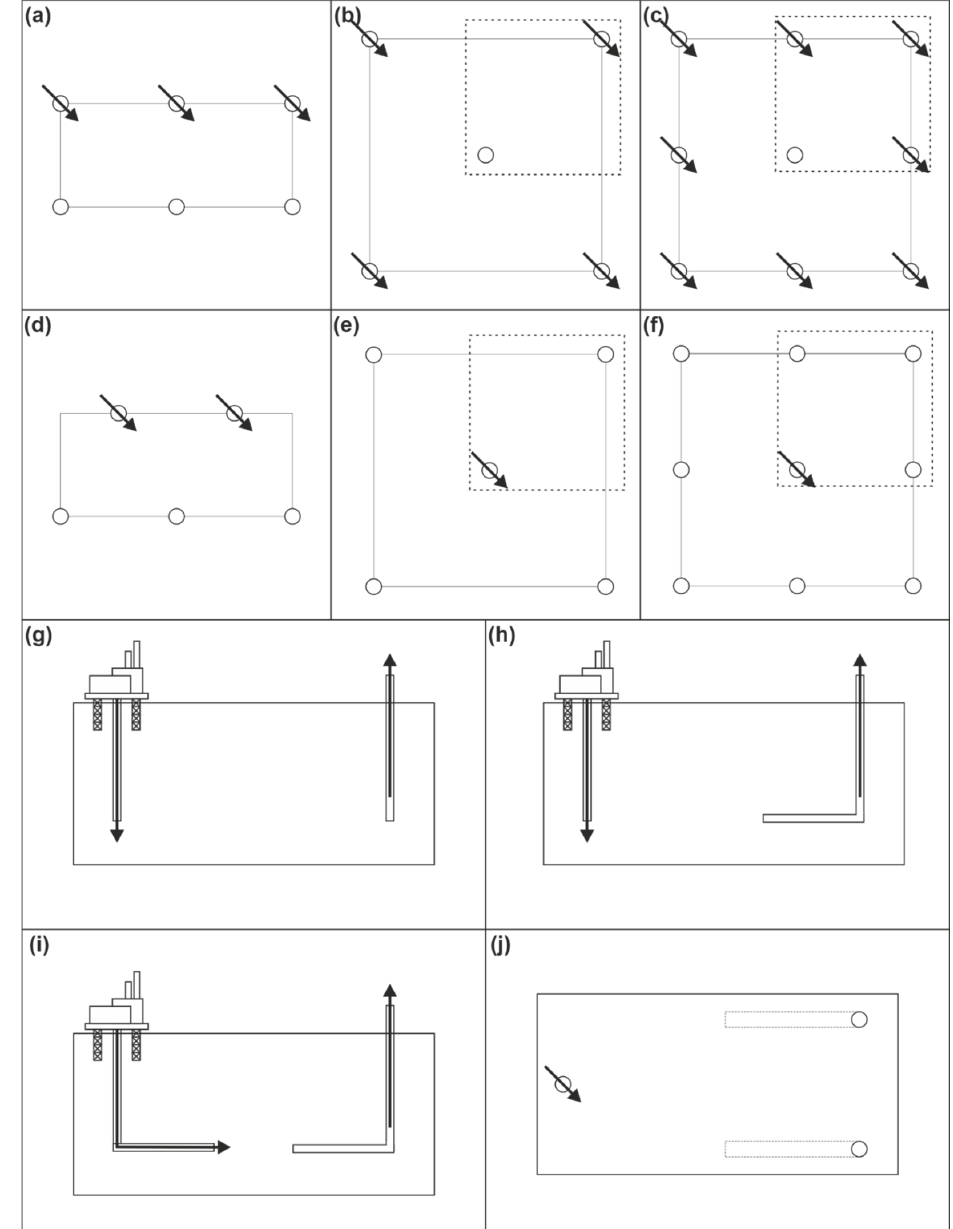
Figure 12. Schematic diagrams showing various well configurations with arrows indicating injec- tors and dotted lines showing ¼ spot patterns, commonly used in simulations to reduce time and computing power required. ( a) Direct line drive configuration; (b) five-spot pattern (c); nine-spot computing power required. ( a ) Direct line drive configuration; ( b ) five-spot pattern ( c ); nine-spot pattern (d); staggered line drive (e); inverted five-spot (f); inverted nine-spot (g); vertical injector vertical producer (VIVP); (h) vertical injector horizontal producer (VIHP) (i); horizontal injector hor- pattern ( d ); staggered line drive ( e ); inverted five-spot ( f ); inverted nine-spot ( g ); vertical injector izontal producer (HIHP); and (j) Vertical injector two horizontal producers, set in a staggered line vertical producer (VIVP); ( h ) vertical injector horizontal producer (VIHP) ( i ); horizontal injector drive (VI2HP). horizontal producer (HIHP); and ( j ) Vertical injector two horizontal producers, set in a staggered line drive